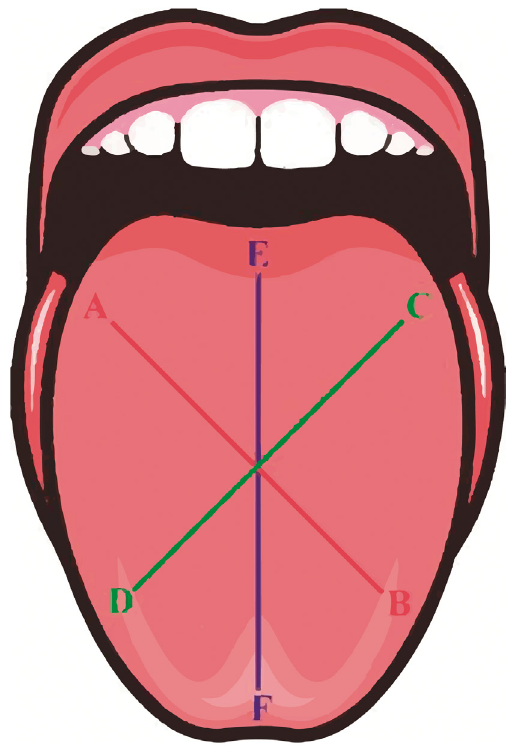
Figure 1- Movements involved in the execution of the X technique. First movement (A-B); second movement (C-D); third movement